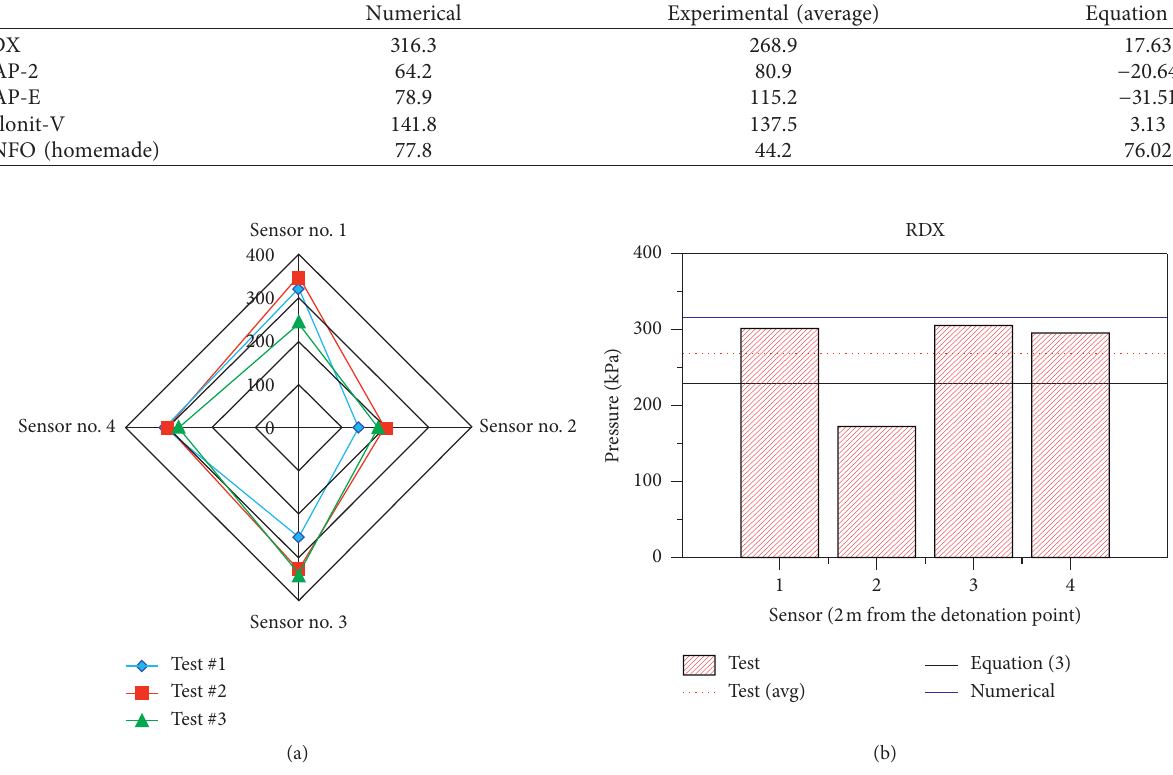
Figure 10: Experimental, analytical, and numerical pressure peaks: (a) example of a typical experimental record (RDX charge, pressure values in kPa, and at 2 m from the detonation point) and (b) the corresponding pressure peak comparisons